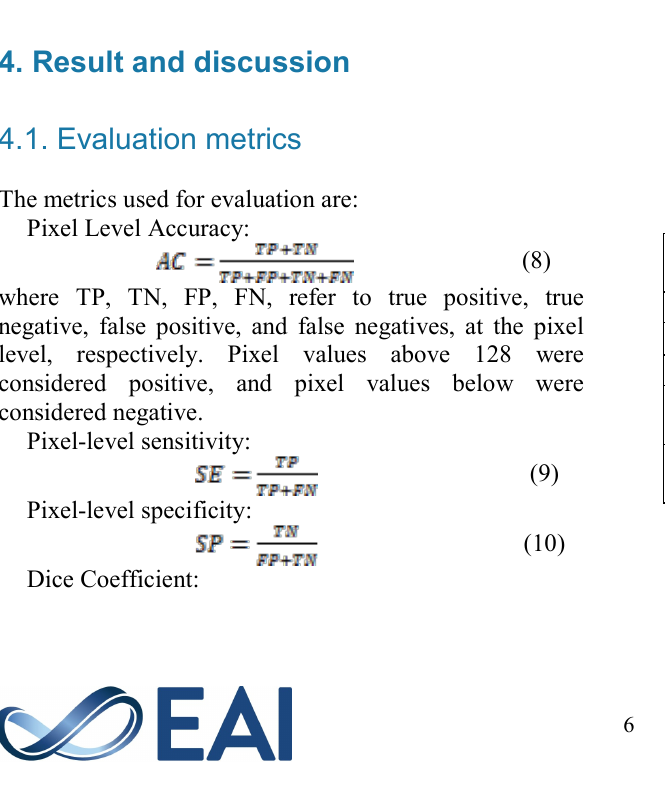
Figure 10. Results of disk removing